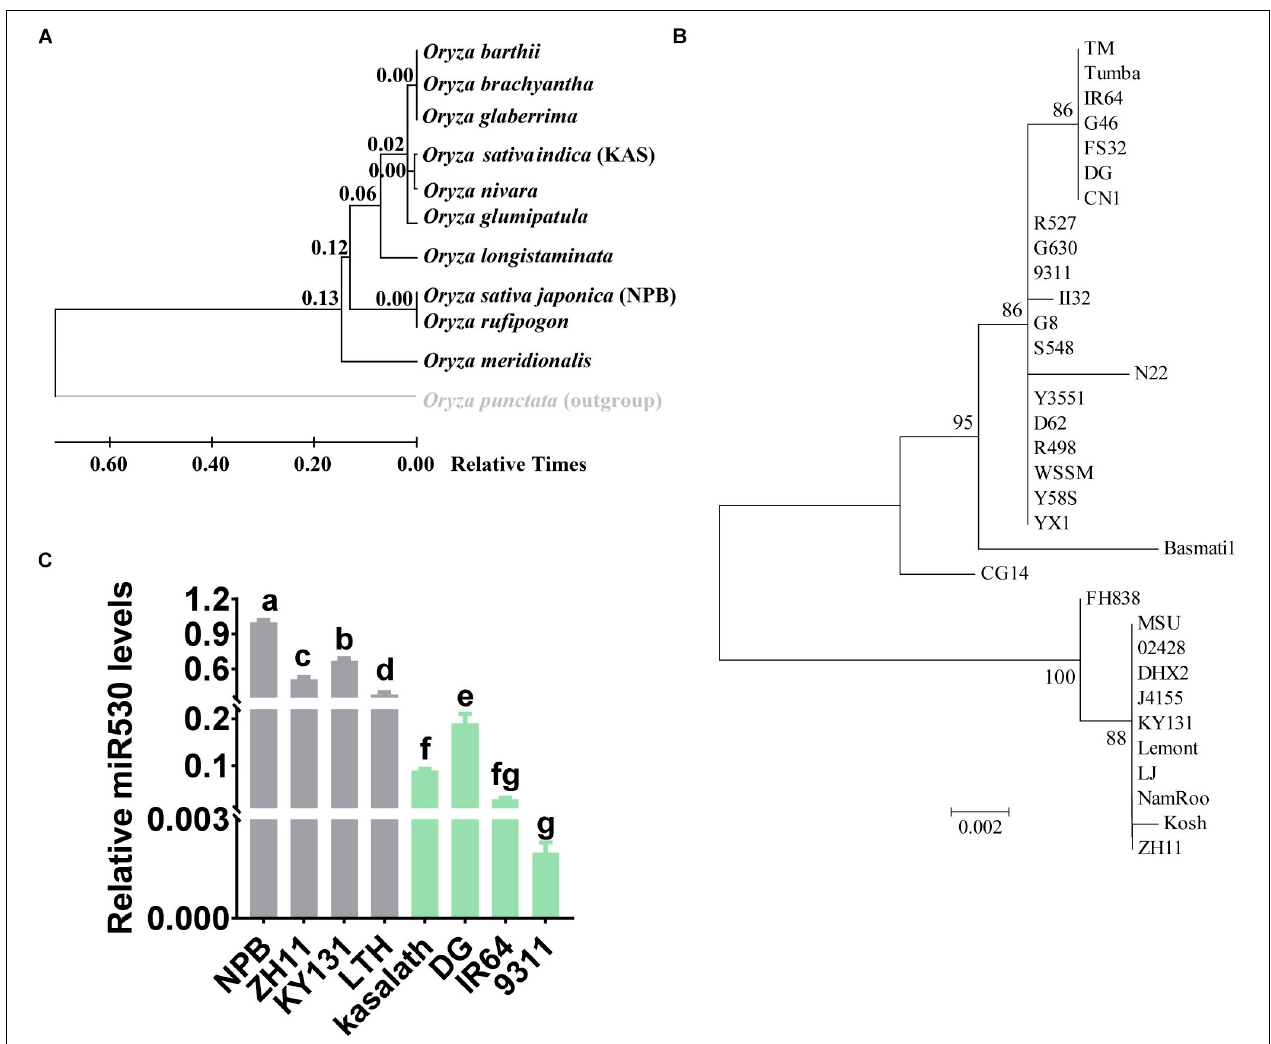
FIGURE 7 | MIR530 was diverse in rice species. (A) Phylogenetic tree inferred by analyzing the sequences of MIR530 gene (miR530 precursor with 1,000-bp upstream promoter sequence) in 11 wild rice species using the neighbor-joining method. The numbers at the nodes are relative divergence times. (B) Phylogenetic tree inferred by analyzing the MIR530 gene in 32 O. sativa accessions covering all known subpopulations and an Oryza glaberrima accession. The numbers at the nodes are relative divergence times. (C) The relative amount of mature miR530 in the indicated O. sativa japonica and O. sativa indica accessions. The RT was carried out with total RNA and miR530-specific stem-loop RT primer ( Supplementary Table 1 ). The RT product was subsequently used as a template for qPCR to detect the amounts of miR530. The amounts of snRNA U6 were detected and used as an internal